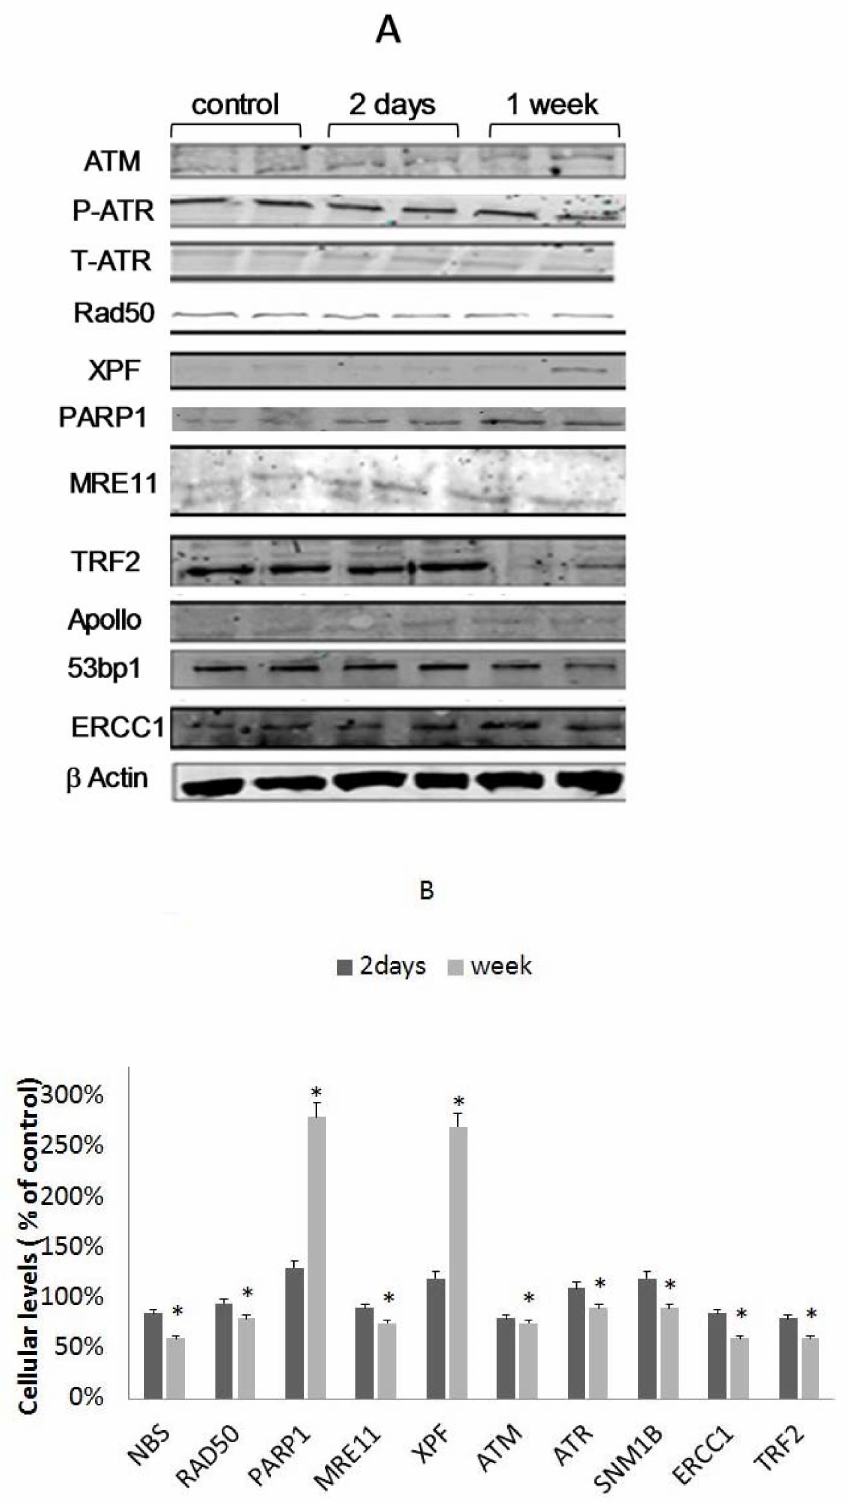
Figure 3. The cellular levels of TRF2 binding proteins. pHFF cells were exposed to 25 mM ethanol for two days and the level of the TRF2 binding proteins was assessed by Western immunoblot. ( A ) A representative example of the Western blots; ( B ) quantitation of A, performed by the VersaDoc densitometer quantitation apparatus. * pV <